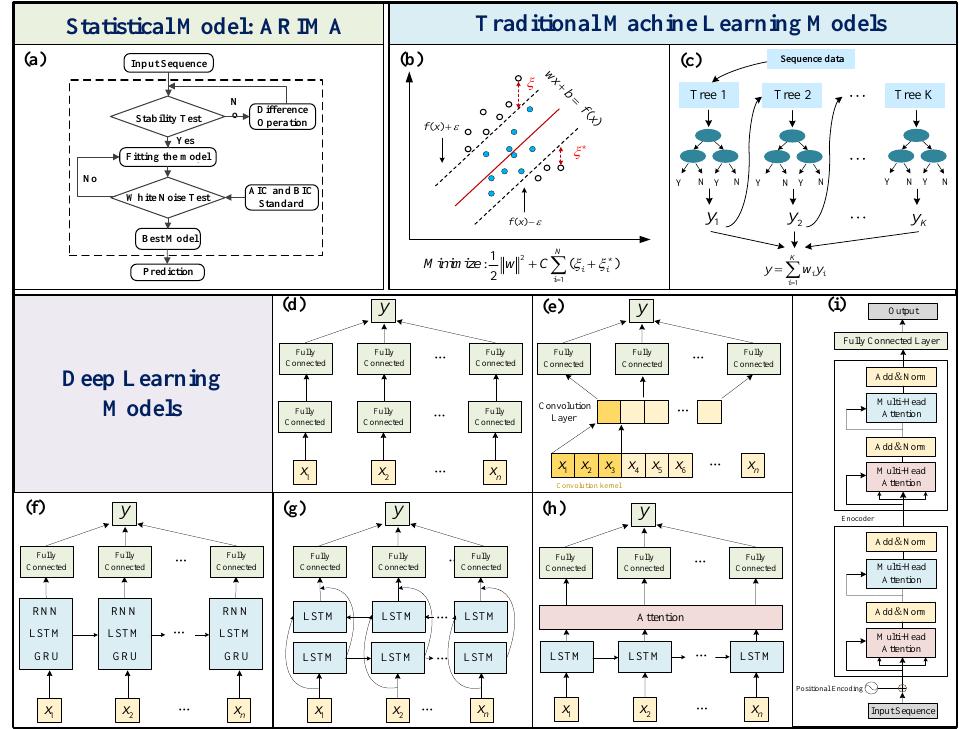
Figure 5. Employed statistical and machine learning models. ( a ) Workflow of ARIMA model, ( b ) Workflow of SVR, ( c ) Workflow of XGBoost, ( d ) Workflow of Conventional DNN, ( e ) Workflow of CNN, ( f ) Workflow of RNN/LSTM/GRU, ( g ) Workflow of BiLSTM, ( h ) Worflow of Attention-LSTM, ( i ) Workflow of Transformer.